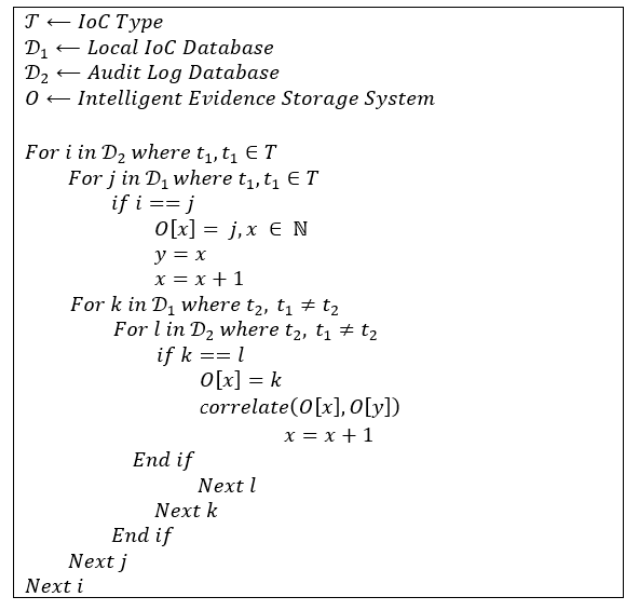
Figure 4. The algorithm of the threat identification module [6].